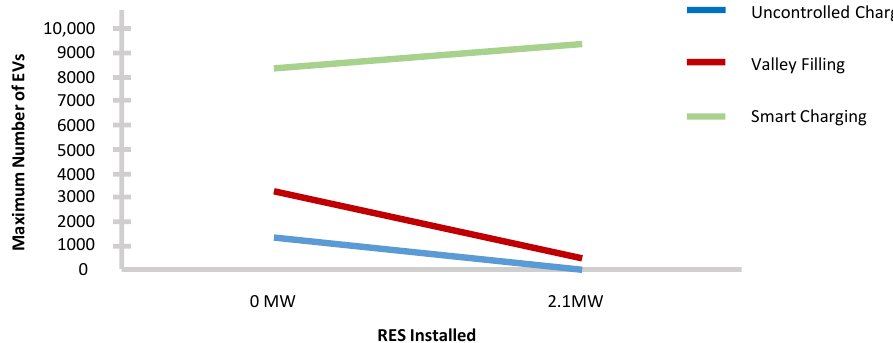
Figure 12. Relation between the maximum allowed number of EVs and the RESs installed in the network of Ikaria (based on the results of the Merge EU project) [49].